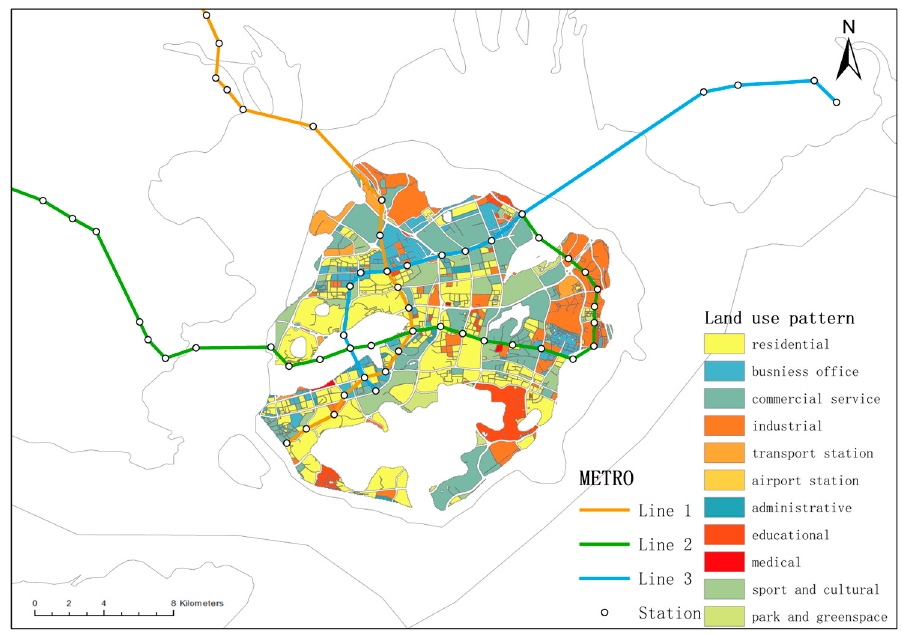
Figure 3. Land use pattern of Xiamen Island (main).